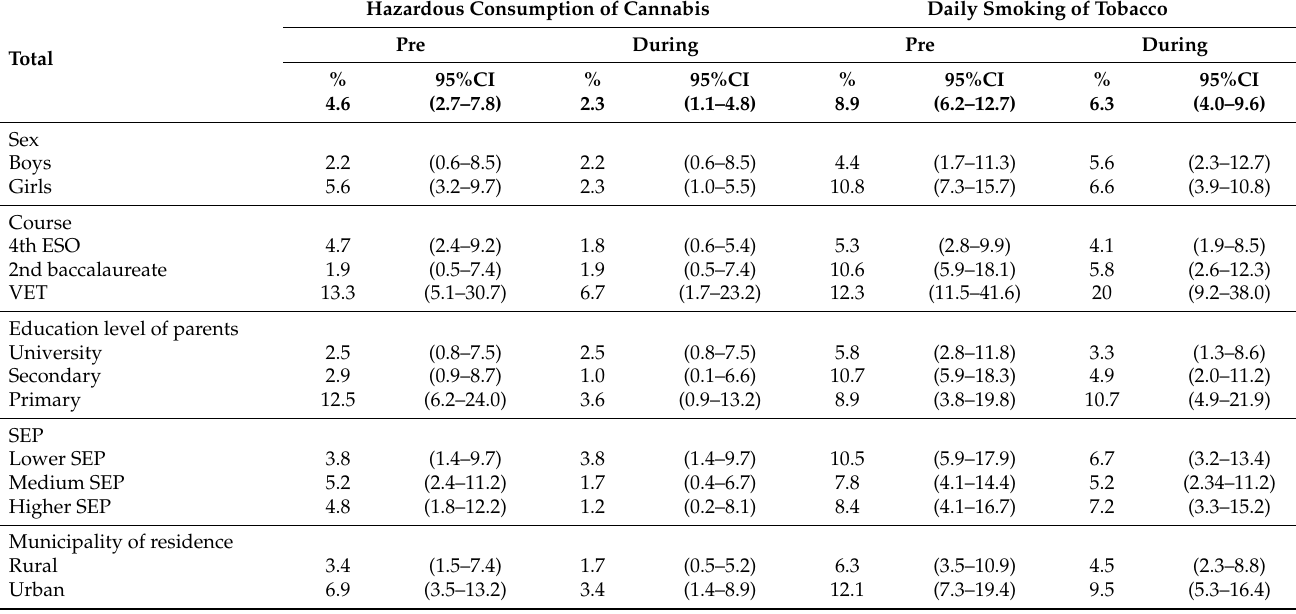
Table 3. Prevalence of hazardous consumption of cannabis, and daily smoking, before and during lockdown due to the COVID-19 pandemic in the 303 adolescents from Central Catalonia who participated in wave 1 and wave 2 of DESK-COVID- Cohort